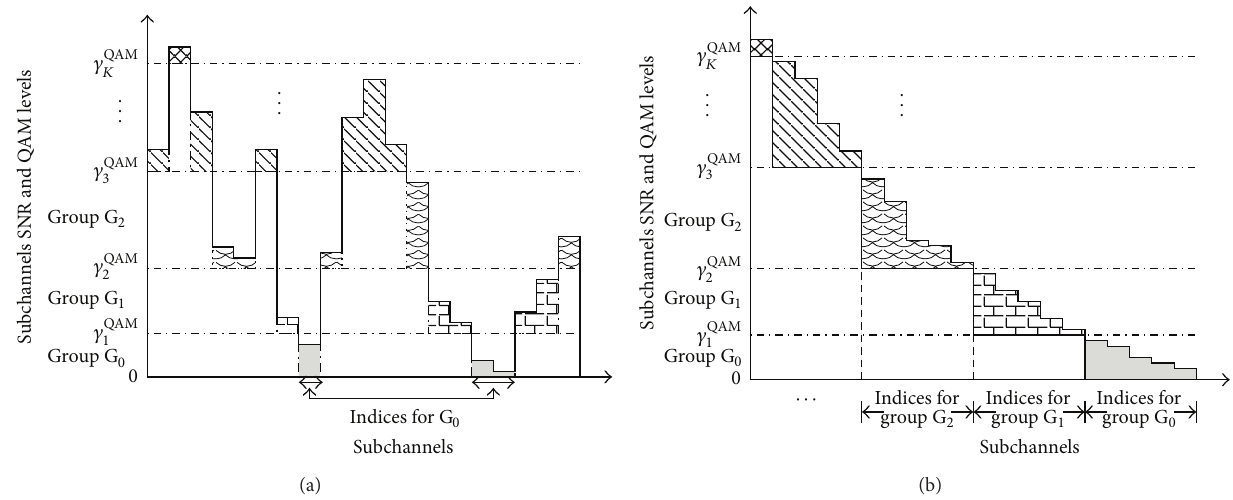
Figure 1: Subchannel grouping into 𝐾 + 1 QAM groups based on their SNRs in (8) and step (3) of Section 2.2 for (a) a multicarrier system and (b) an ordered multicarrier system or a SVD-based MIMO